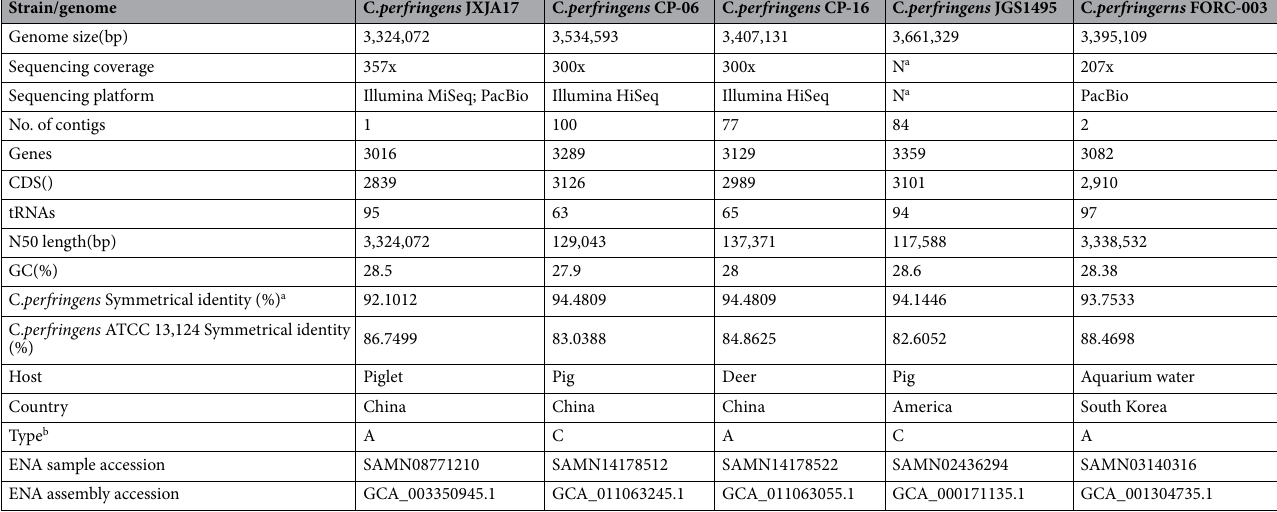
Table 1. General features of the C. perfringens genomes. a This data is unknown. b The strains are classified as A–E type according to α, β, ε and promethium toxins, excluding F and G types.